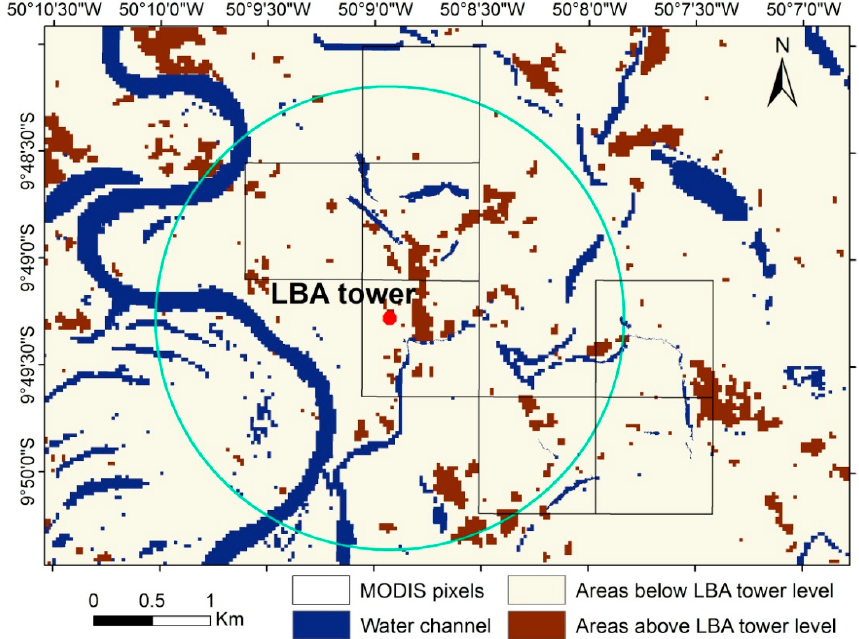
Figure 3. Shuttle Radar Topographic Mission (SRTM) classified as areas below and above the tower level, which is located at 181 meters of altitude (red dot). Grey squares represent the Moderate Resolution Imaging Spectroradiometer (MODIS) pixels within the tower footprint (green circle, Borma et al. [42]) selected to extract mean EVI and be analyzed.